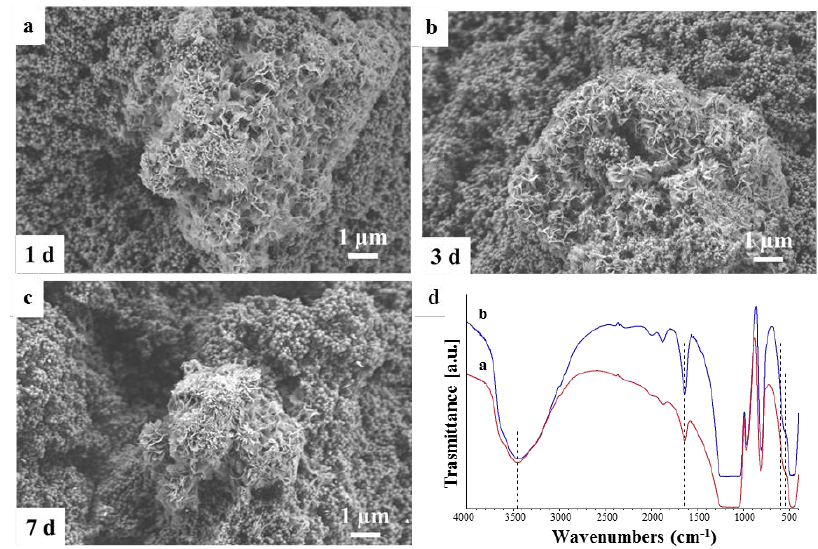
Figure 3. SEM micrographs and FTIR spectra of Ca_MCM-41 particles after immersion in simulated body fluid (SBF) at different time points. SEM image after 1 day ( a ), 3 days ( b ), 7 days of immersion ( c ); FTIR spectra ( d ) after 3 days ( a ) and 7 days ( b ) of immersion.